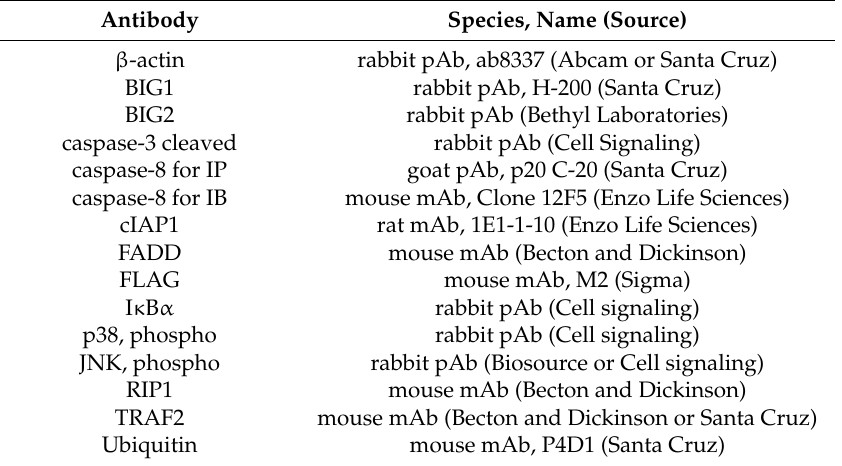
Table A1. Antibodies used in this study are